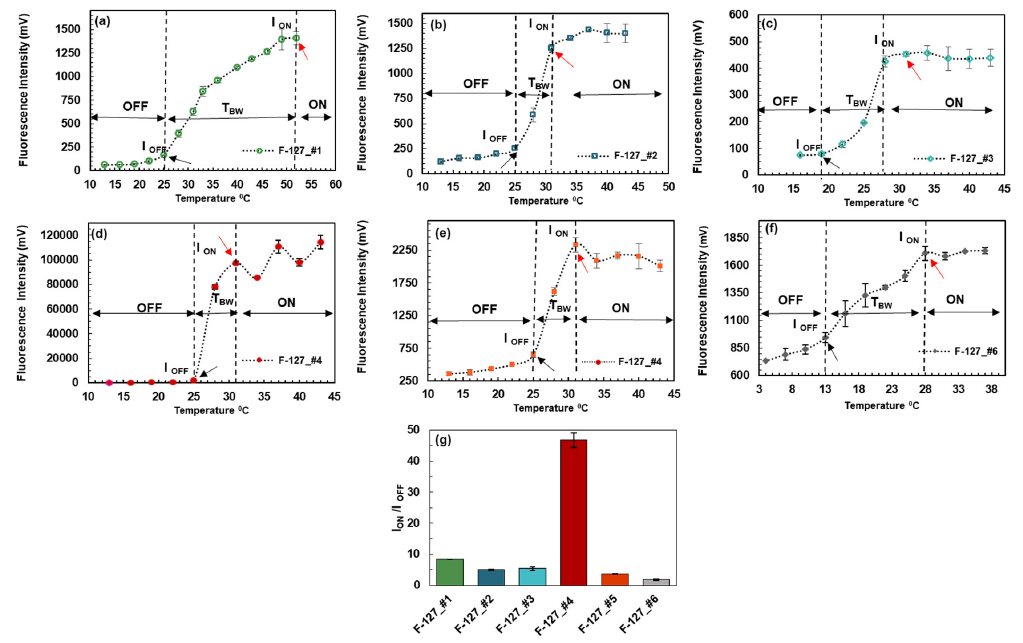
Figure 5. ( a – f ) Response of Pluronic F-127 loaded with fluorophores to the change in temperature. Black arrows show the LCST and red arrows the first local maximum (major slope change in the case of a plateau). ( g ) Pluronic F-127 nanoparticles loaded with fluorophore 4 acted as a very strong switch. Both F-127 nanoparticles loaded with fluorophore 2, 3 and 5, act as moderate switches. F-127 nanoparticles loaded with fluorophore 1, and 6 did not qualify as a switch due to having a large T BW ( ≥ 15 °C). (Values are based on Edge method).